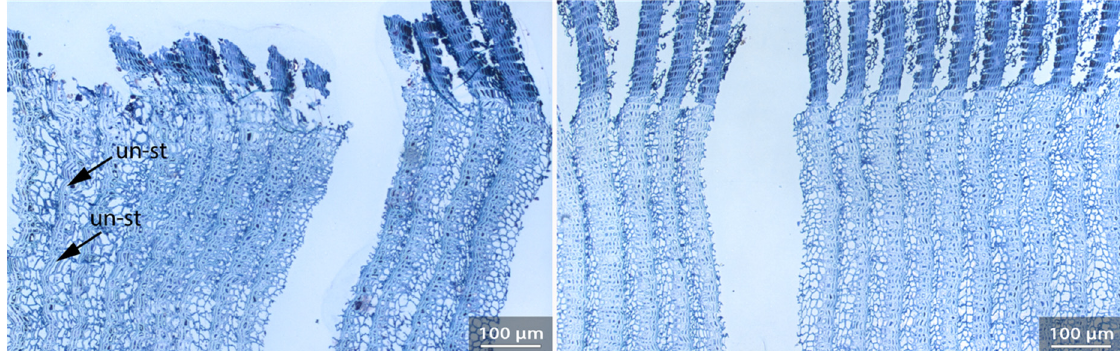
Figure 20. Sample 4. Two thin sections, about 4 mm apart, were made from the embedded sample: thin section 4a (left) and thin section 4b (right). Thin section 4b reveals a much better-preserved cell structure than 4a: it is regular, walls of thin-walled cells are still slightly folded and there is only slight light blue staining of secondary cell walls, an indication of low water sorption; thin section 4a shows unfolding of thin-walled cells and stretching of thick-walled cells (un-st).